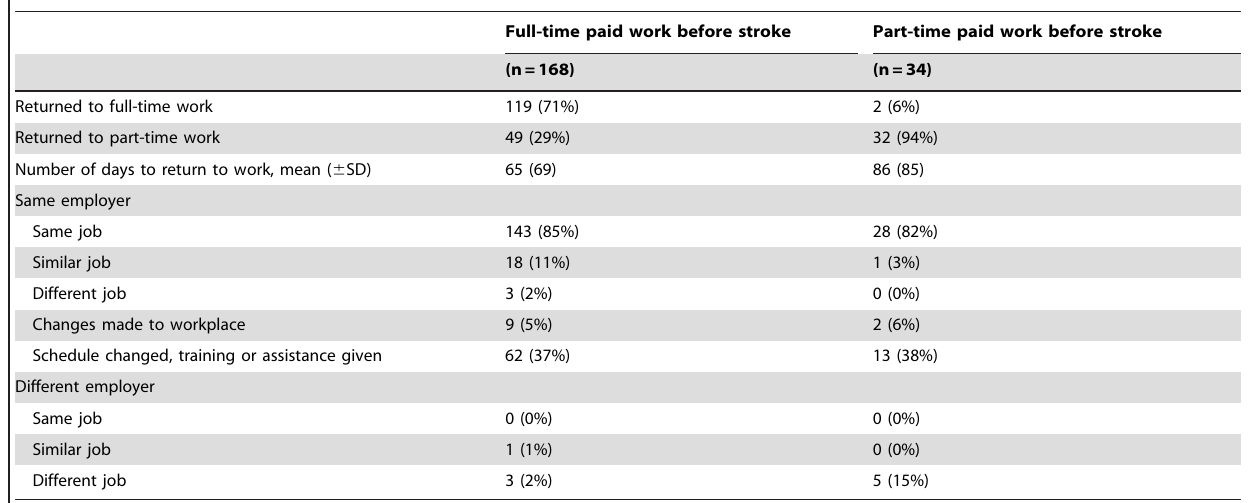
Table 2. Work situation for those who returned to paid work in the first year after stroke.